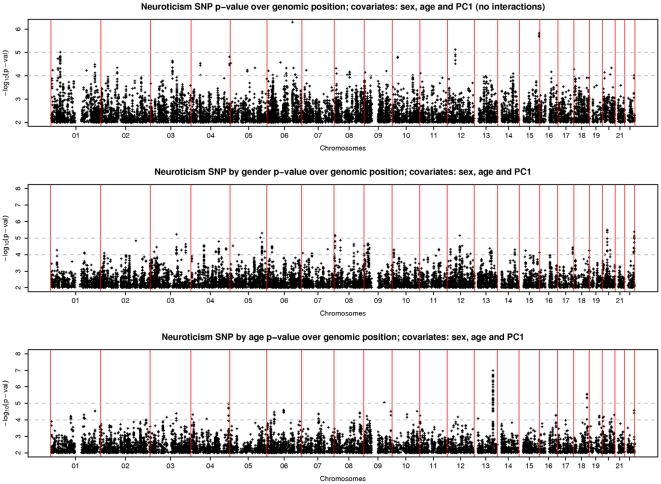
P-values over genomic location.-log10(p-value) for association with EPQ-N, against genomic location for 1.7 M genotyped and well-imputed SNPs. Top: main SNP effect; middle: sex by SNP interaction; bottom: age by SNP interaction.